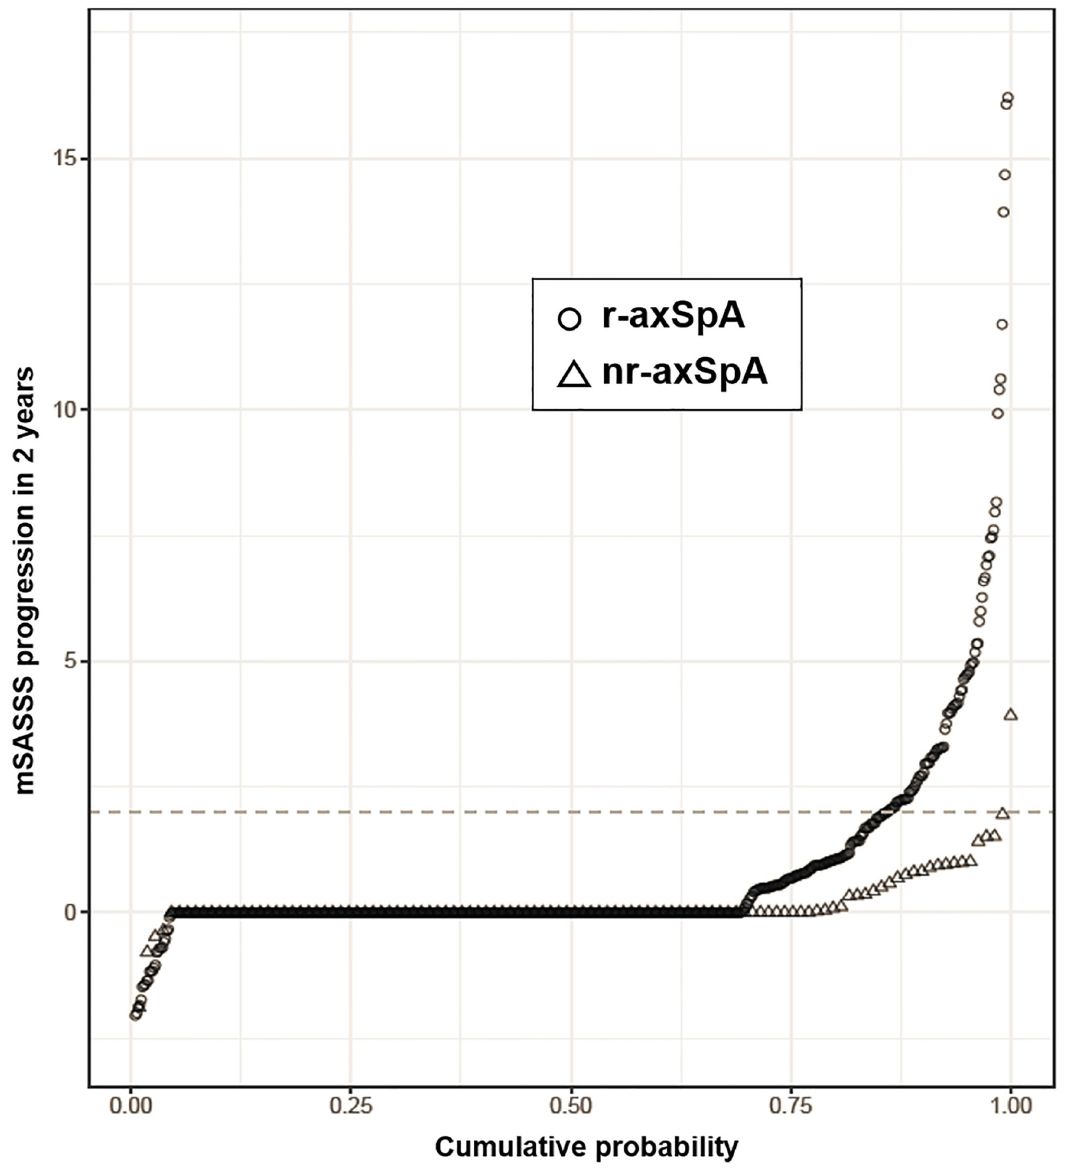
Fig 3. 2-year progression in the modified Stoke Ankylosing Spondylitis Spine Score (mSASSS) depicted in a cumulative probability plot. The change in mSASSS values from start to end of individual 2-years radiographic intervals is shown for r-axSpA patients (circles) and for nr-axSpA patients